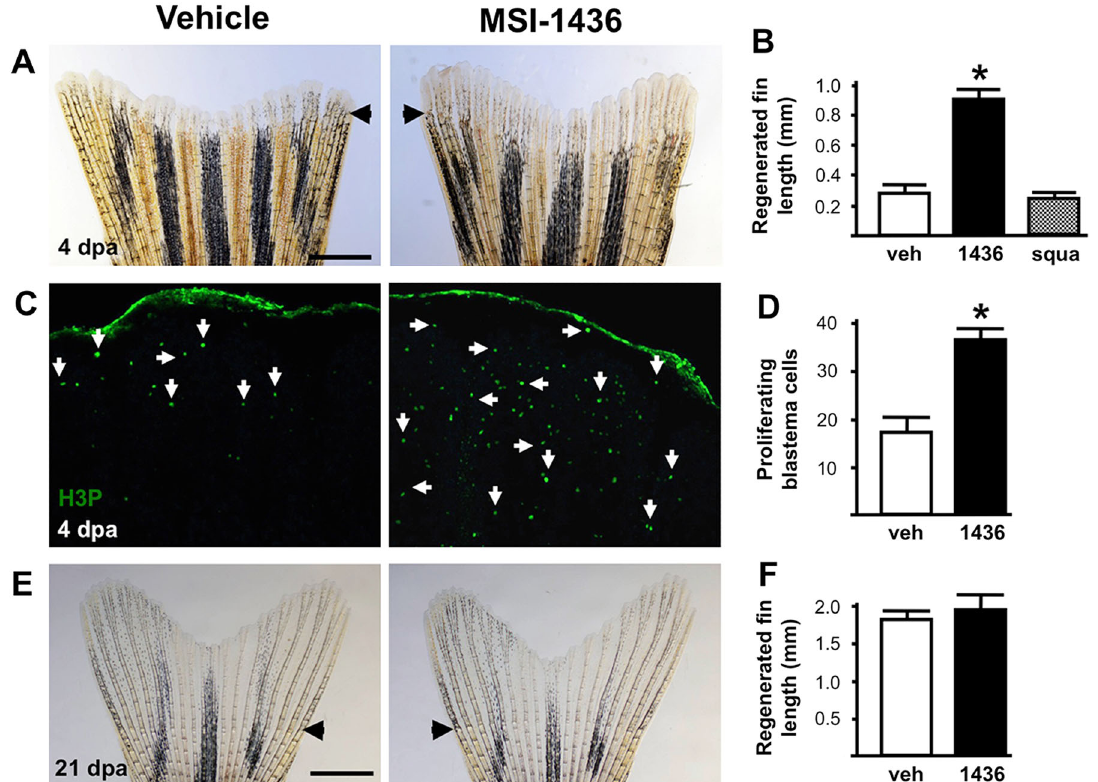
Fig. 1 MSI-1436 stimulates adult zebra fi sh caudal fi n regeneration. a Representative images of caudal fi n regeneration 4 days post- amputation (dpa) in vehicle- and MSI-1436-treated fi sh. b Quanti fi cation of regenerated caudal fi n length 4 dpa. Values are means ± S.E. ( n = 12 – 16). * P < 0.01 compared to vehicle-treated fi sh. c Representative images of caudal fi n blastemas immunostained with antibodies to phosphorylated histone 3 (H3P). Arrows show H3P-positive cells. d Quanti fi cation of H3P-positive cells 4 dpa. Values are means ± S.E. ( n = 6 – 8). * P < 0.01 compared to vehicle-treated fi sh. e Representative images of caudal fi n morphology after regeneration is complete at 21 dpa. f Quanti fi cation of regenerated caudal fi n length 21 dpa. Values are means ± S.E. ( n = 10). Fish were given daily given intraperitoneal (IP) injections of either vehicle, 0.125 mg/kg MSI-1436 or 0.125 mg/kg squalamine (squa) following caudal fi n amputation. Arrowheads ( a , e ) show location of amputation plane. Scale bar ( a , e ) = 1